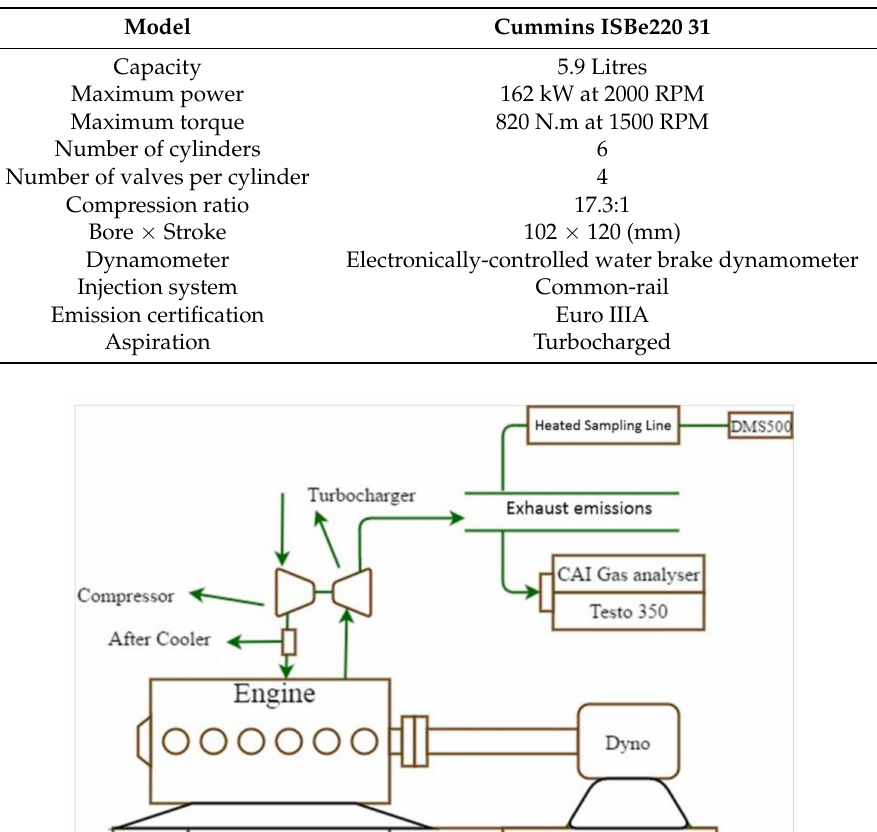
Table 3. Test engine specification.